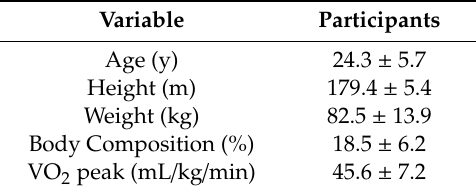
Table 1. Participant